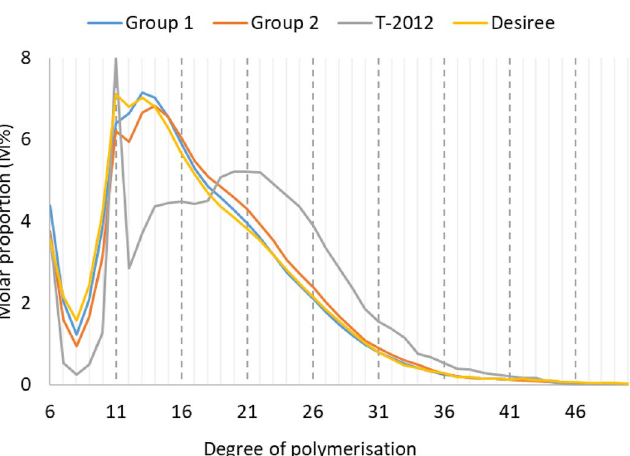
Figure 3. Chain-length distribution of debranched starches on a relative molar basis (M%) with degree of polymerization (DP) 6–50, based on HPAEC analysis with averages of potato lines from Groups 1 and 2. No peak was detected for the starches from Group 3. The parental variety Desiree and the high-amylose line T-2012 were included for